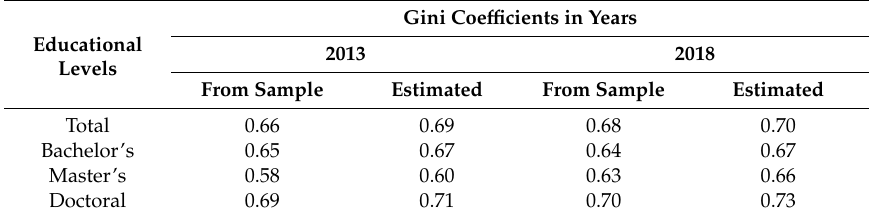
Figure 2. Lorenz concentration curves for electricity and energy education in the EU countries in 2018. Table 1. Gini coe ffi cients for education levels in the fields of electricity and energy in the EU countries in